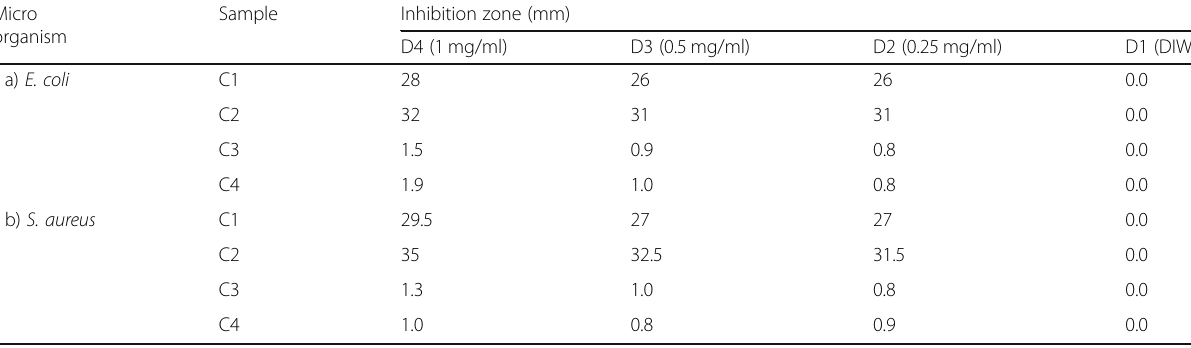
Table 1 Antimicrobial activity of C1, C2, C3, and C4